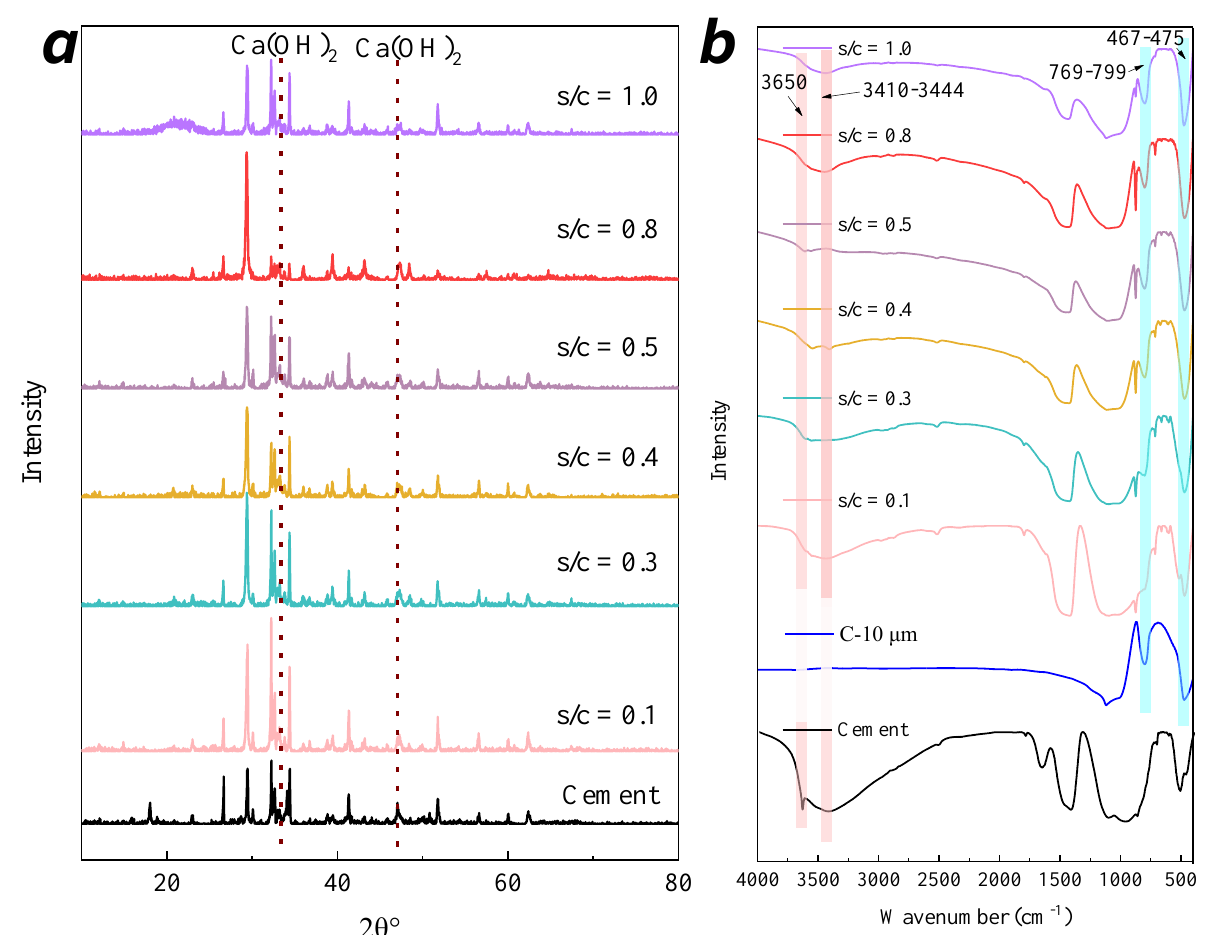
Figure 4. Effect of s/c on microstructure and surface functional groups of CMs. ( a ) XRD patterns of CMs with different s/c ratios; ( b ) FT-IR spectra of CMs with different s/c ratios.